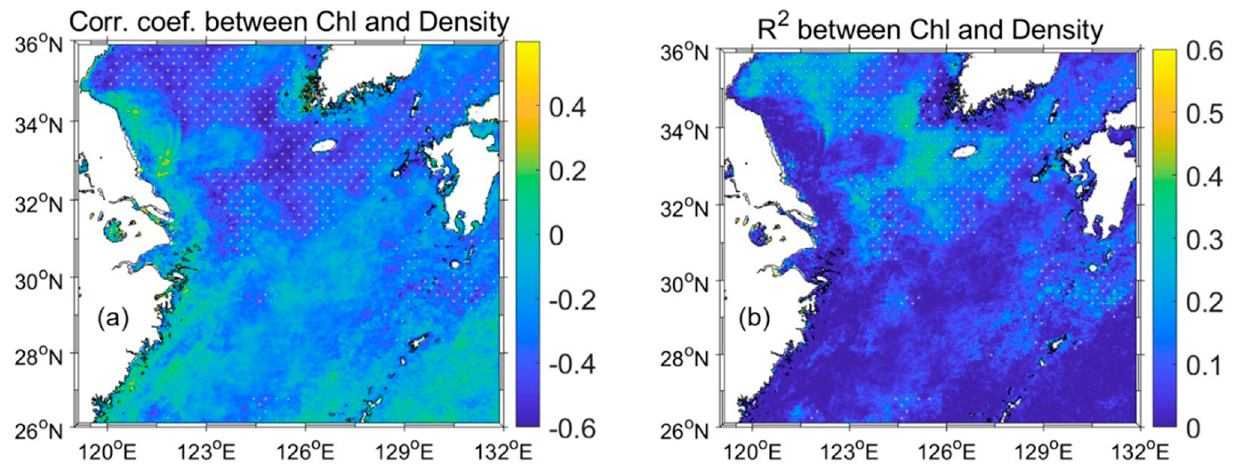
Figure 8. ( a ) Correlation coefficient and ( b ) R 2 between Chl and SSD from 2002 to 2021. The gray cross symbols mark a p -value < 0.05.